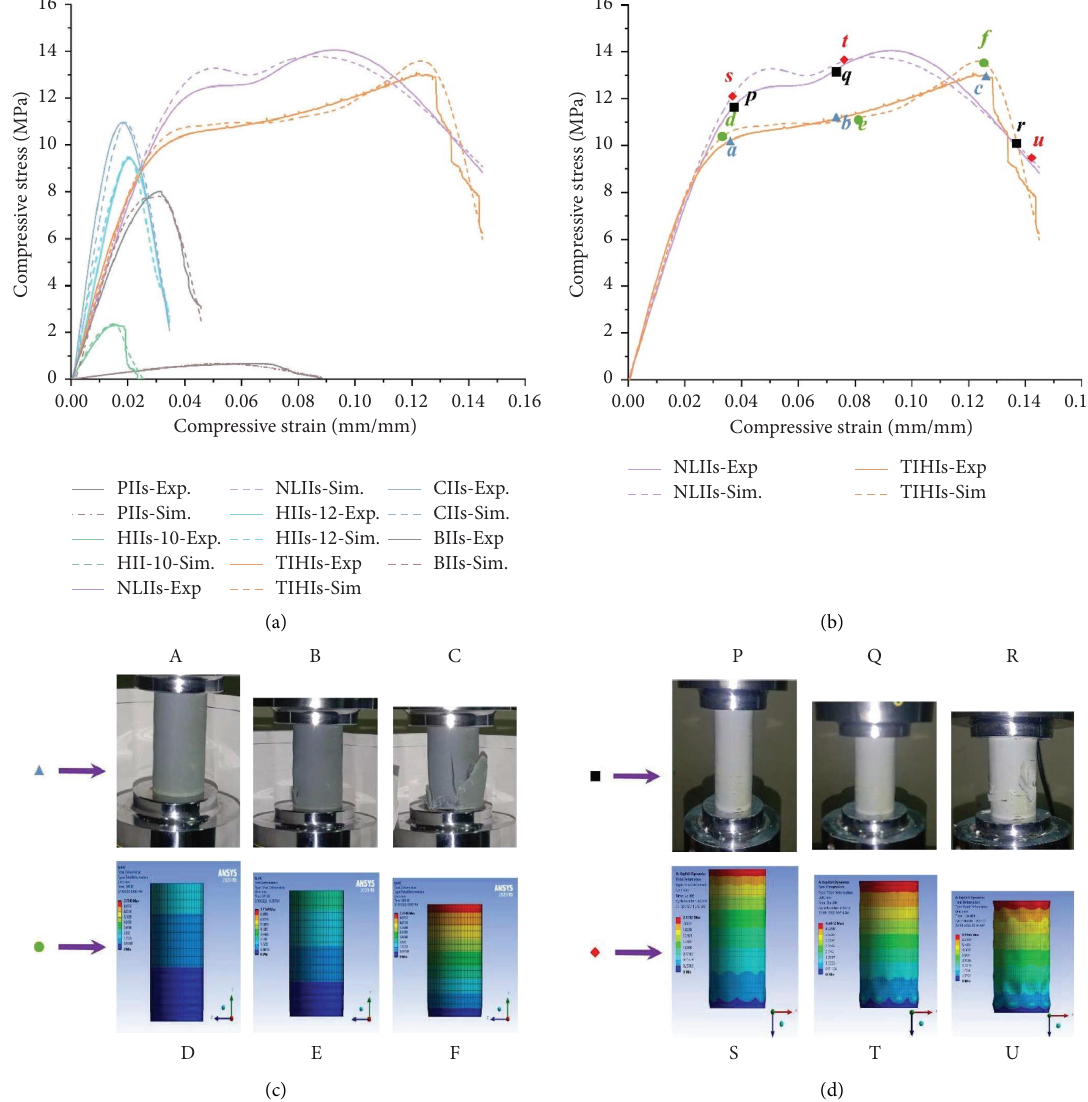
Figure 9: Experimental and simulation stress-strain behaviour of (a) all nature-inspired structures, (b) TIHIs and NLIIs simulation and experimental behaviour, (c) the crushing comparison of TIHI, and (d) the crushing comparison of NLIIs.